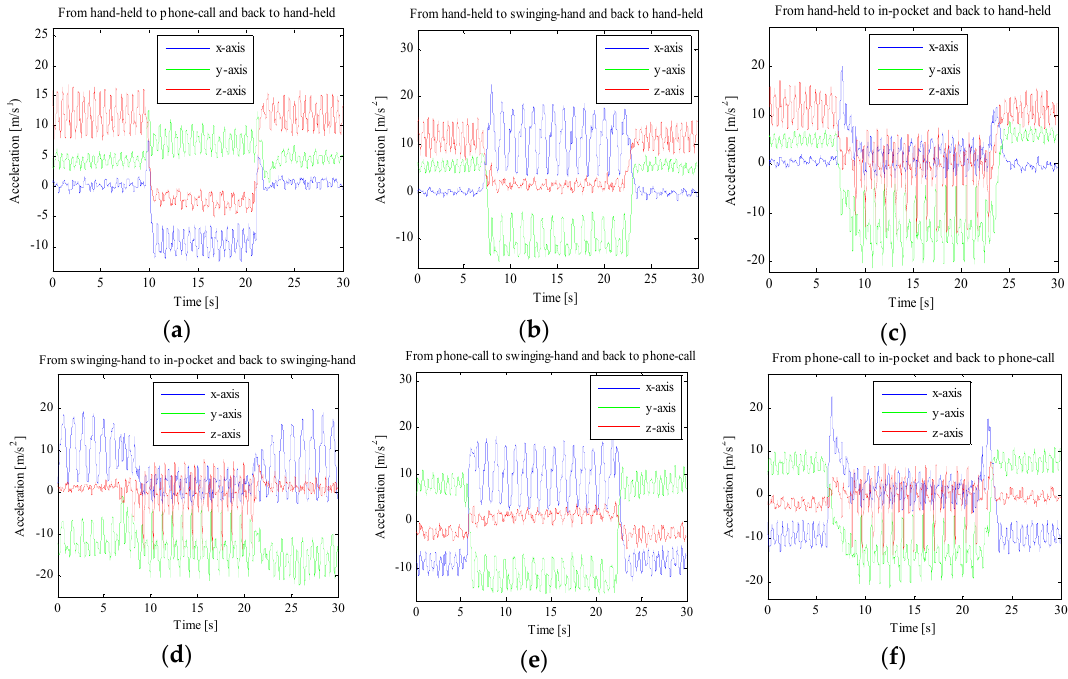
Figure 4. Acceleration signals with all kinds of carrying position transitions: ( a ) between hand-held and phone-call positions; ( b ) between hand-held and swinging-hand positions; ( c ) between hand-held and in-pocket positions; ( d ) between swinging-hand and in-pocket positions; ( e ) between phone-call and swinging-hand positions; ( f ) between phone-call and in-pocket positions.